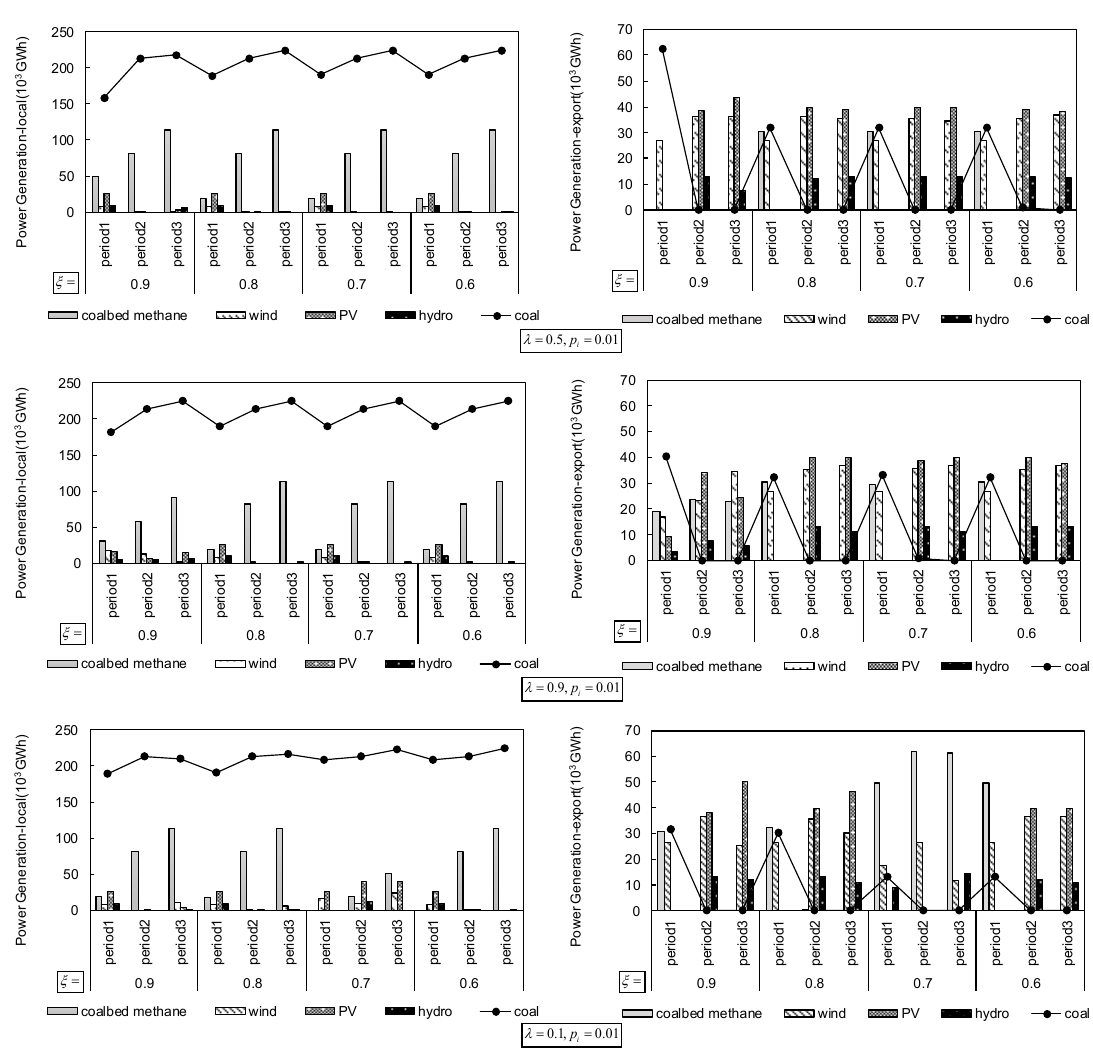
Figure 12. Power generation patterns under different λ values and ξ levels.